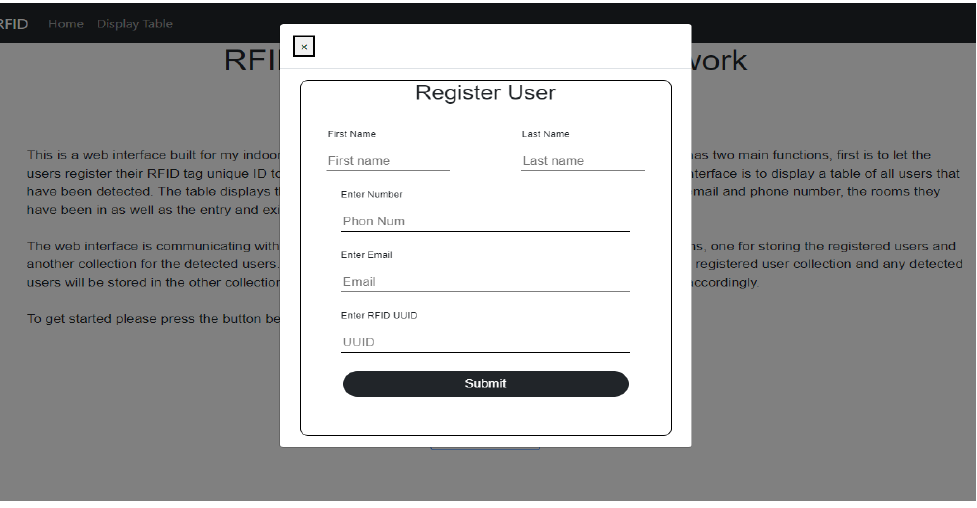
Figure 12. RFID system registration web